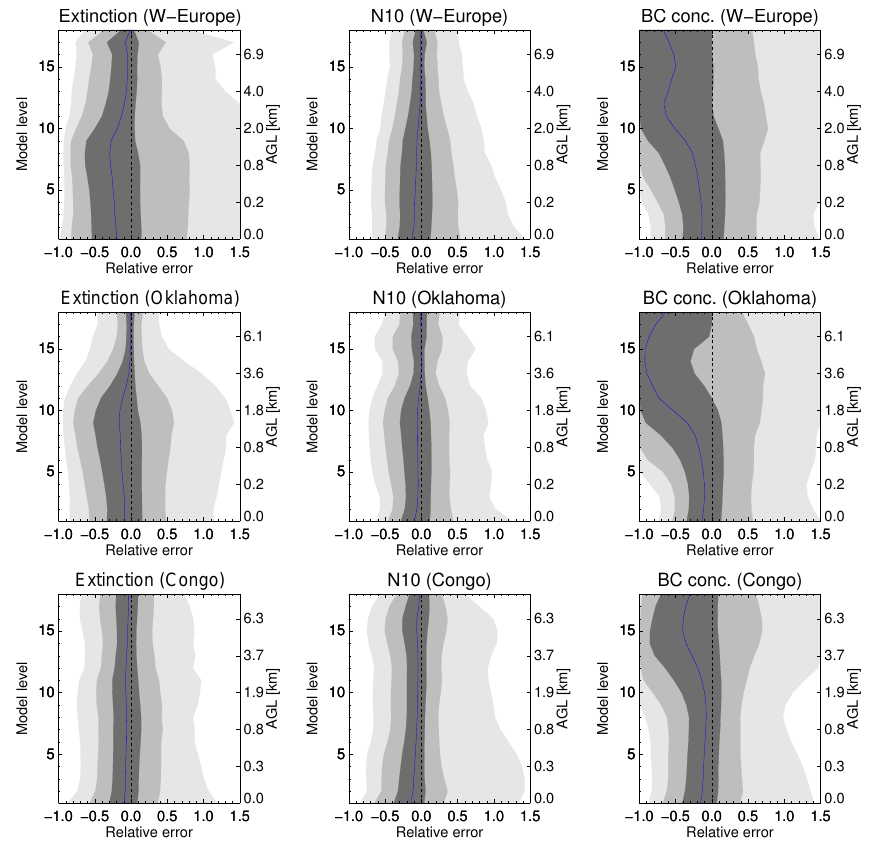
Figure 10. Relative spatial sampling error (instantaneous data) as a function of model level (left vertical axis) and altitude above ground level (a.g.l., right vertical axis) for extinction, N10 and black carbon concentrations. Results for the WRF-Chem MADE simulations. Further explanation in Sect.